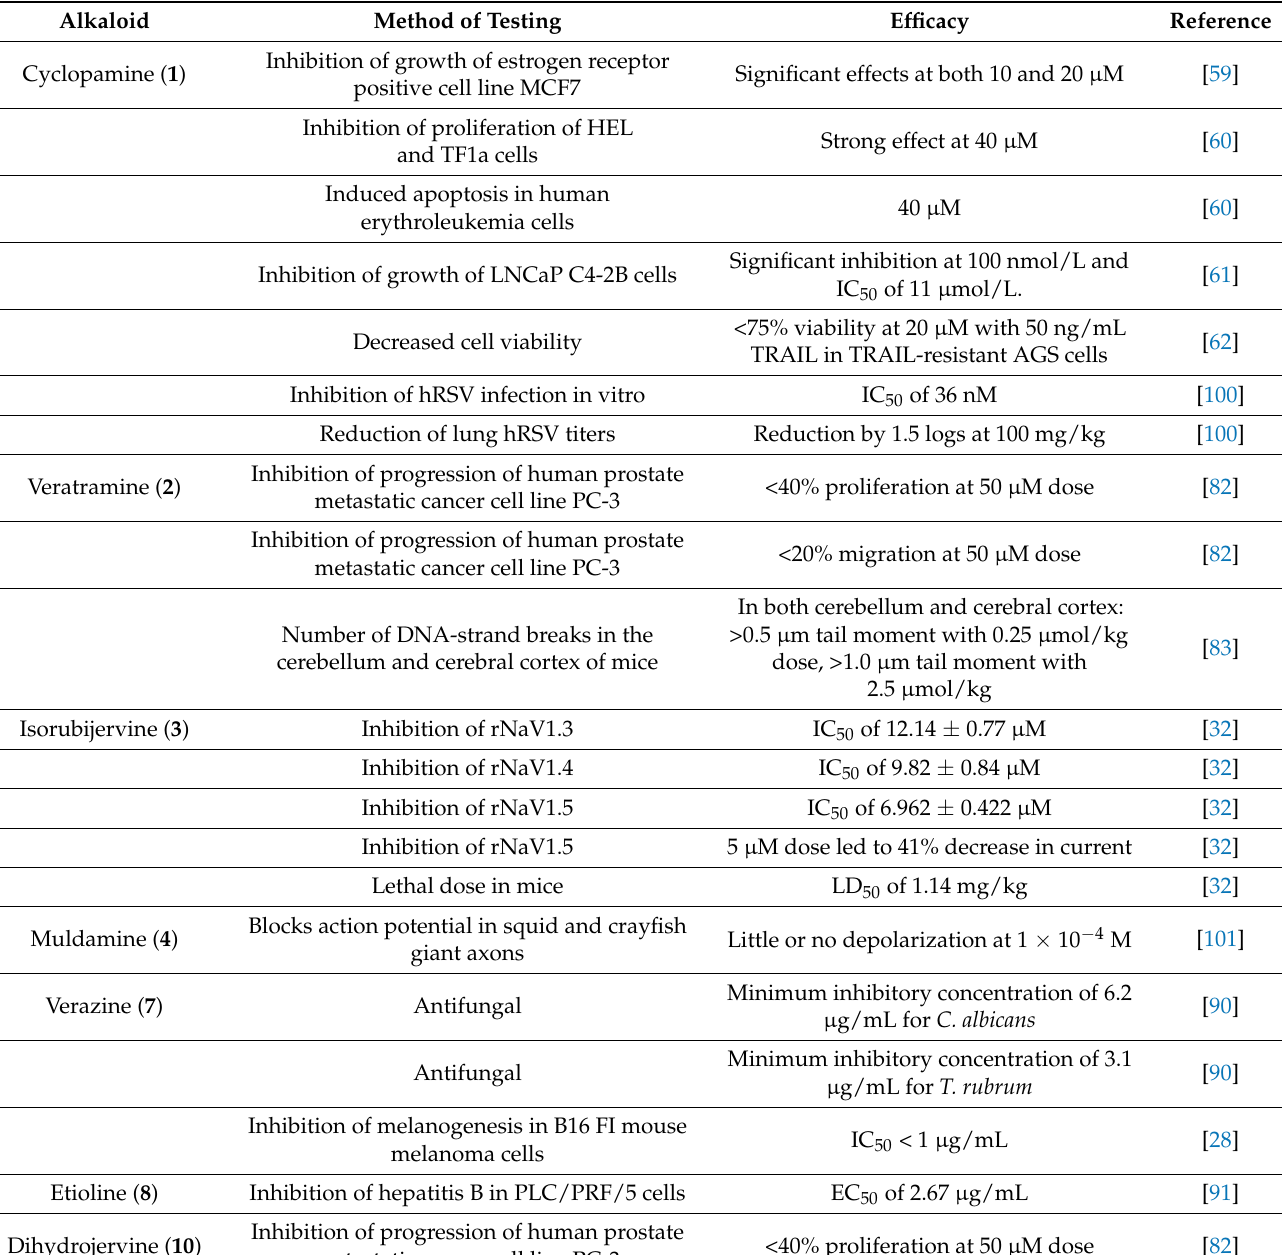
Table 4. Summary of bioactivity in Veratrum californicum